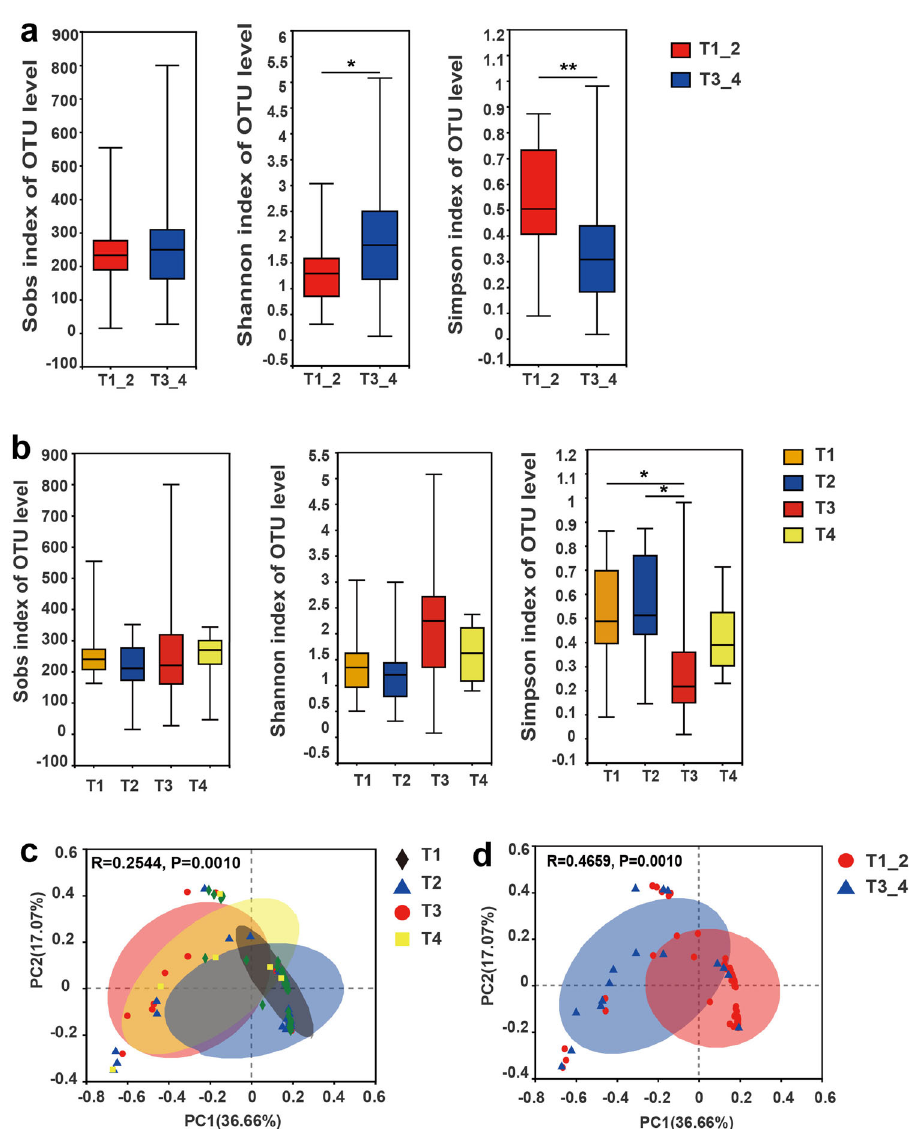
Fig. 1 Changes in the intratumor microbiomes of patients with papillary thyroid carcinoma (PTC) at different clinical stages. a Alpha-diversity ( α